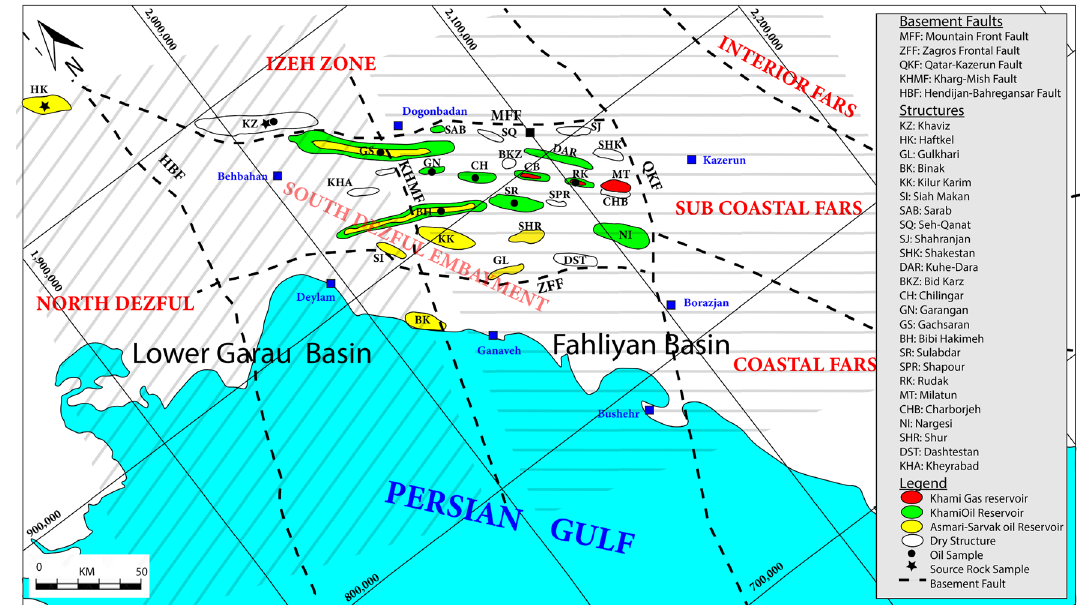
Fig. 1 Structural setting and location map of the studied reservoirs in the South Dezful